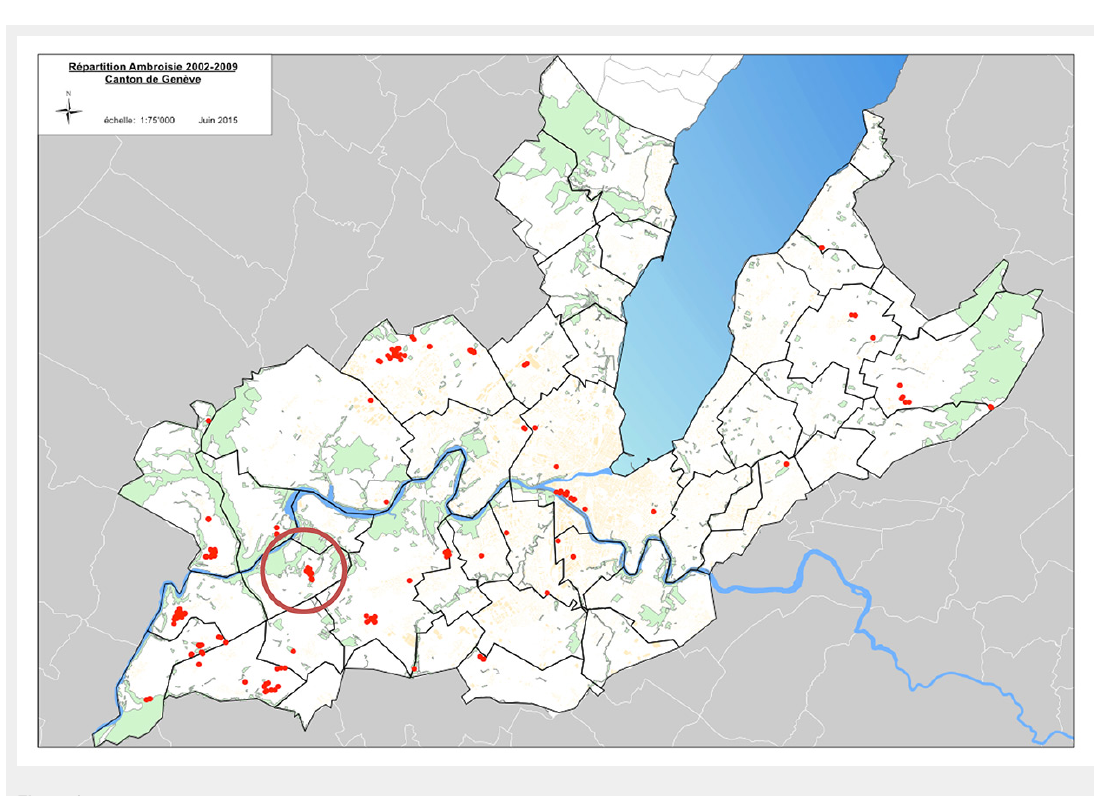
Figure 1 Ragweed invaded areas in Geneva between 2002 to 2009 (red dots). The ragweed invaded location «la Petite Grave» (red